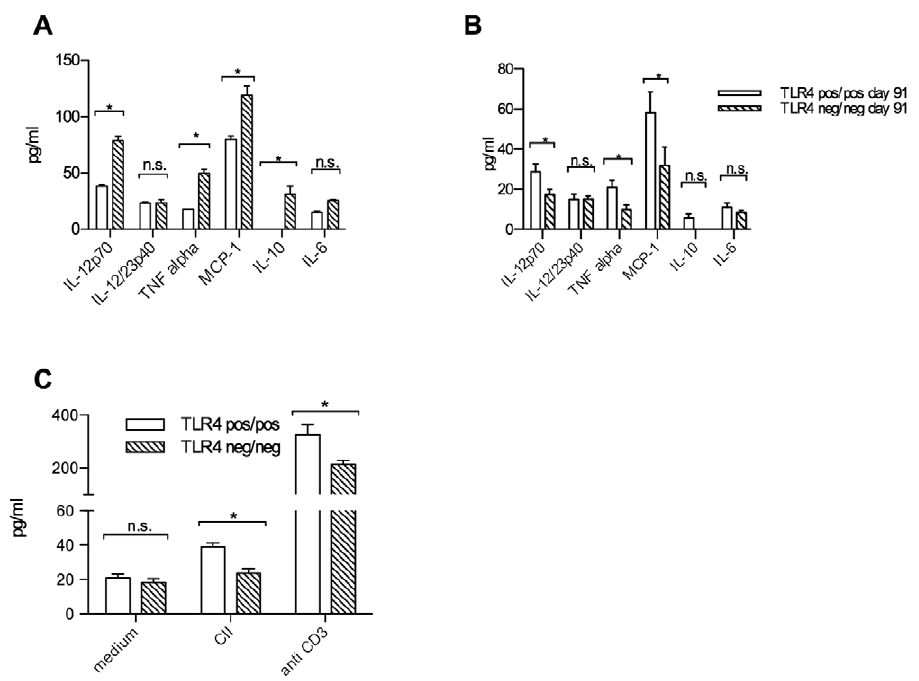
Figure 4. Cytokines in sera and in vitro splenocyte cultures. Serum cytokine concentrations measured at days 34 (A) and 91 (B) in TLR4 negative and TLR4 positive groups of mice. Significantly higher IL-12p70, TNF alpha, MCP-1 and IL-10 concentrations in TLR4 negative groups of mice at day 34 after immunization, while at day 91 IL-12p40, TNF alpha and MCP-1 were higher in TLR4 positive mice. (C) Interleukin17 concentrations are reduced in TLR4 deficient in vitro spleen cell cultures after 48 hours in the presence of type II collagen (100 ug/ml) or anti-CD3 antibodies (1 ug/ ml)(*p , 0,05).